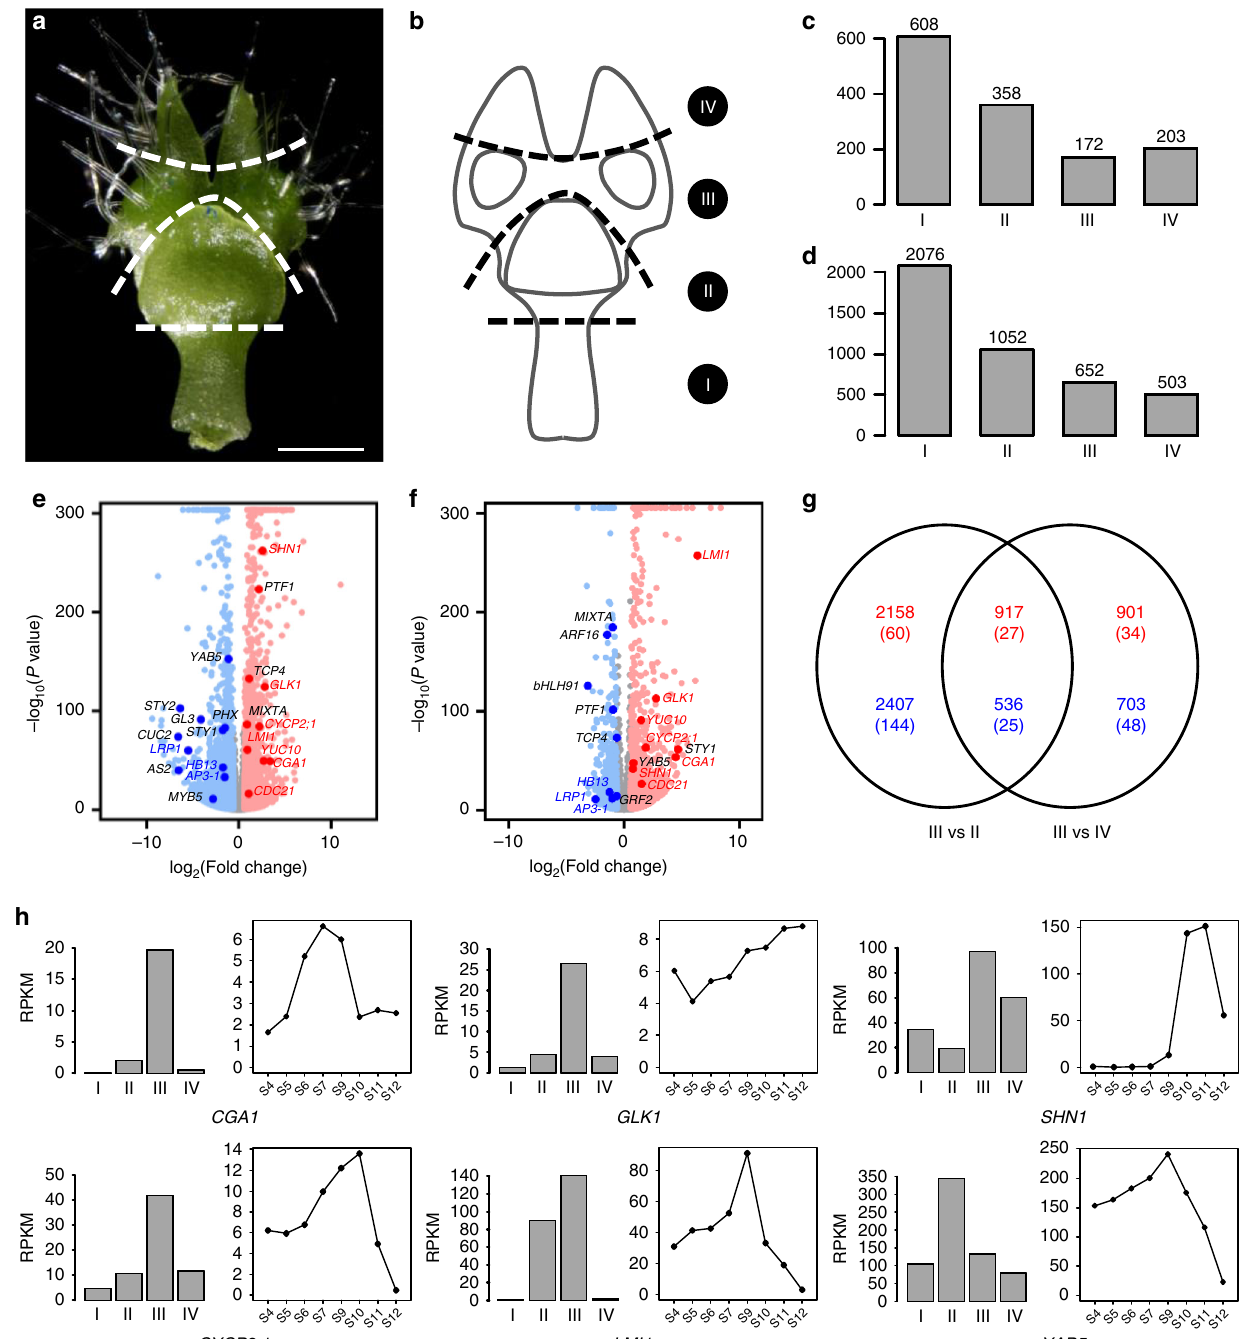
Fig. 4 Identi fi cation of genes involved in pseudonectary formation. a , b Sampling strategy for RNA sequencing of the S9 petal. I, II, III, and IV represent the sampled four parts. Scale bar: 1 mm. For a , the experiments were repeated three times independently with similar results. Histograms showing the number of genes speci fi cally ( c ) and preferably ( d ) expressed in each part. Volcano plots showing differentially expressed genes in Part III relative to Part II ( e ) and Part IV ( f ). The up- and downregulated genes are shown with red and blue dots, respectively, while the genes showing no signi fi cant expression changes are represented by gray dots. Representative genes homologous to the well-known regulators are highlighted with enlarged dots, with red and blue fronts standing for up- and downregulated genes, respectively, in both comparisons, while black front representing up- or downregulated genes in one comparison. g A Venn diagram showing the numbers of up- and downregulated genes (red and blue, respectively) in the two comparisons shown in e and f . A number of TFs are shown in brackets. h The spatiotemporal expression patterns of representative candidate